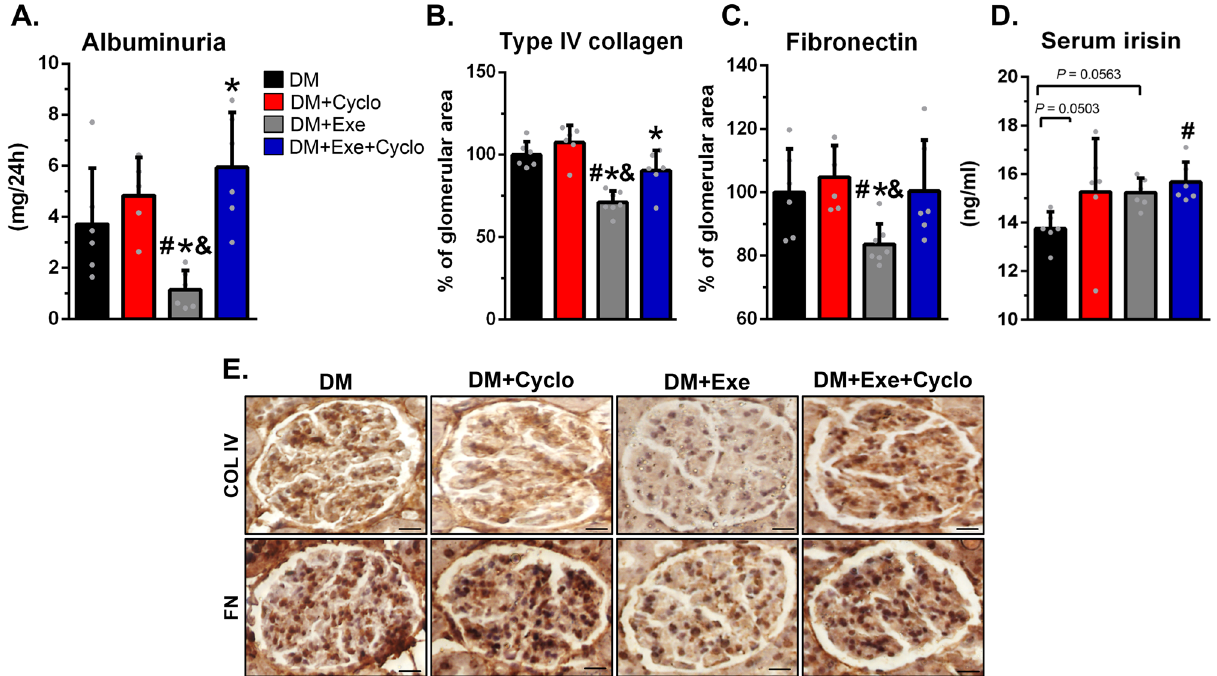
Figure 3. Treatment with an irisin blocker abolished the beneficial effects of aerobic physical exercise in diabetic rats. ( A ) Albuminuria. ( E ) Photomicrography of glomerular immunohistochemistry for type IV collagen and fibronectin (magnification: × 630). ( B , C ) Graphical quantitation of immunohistochemistry for type IV collagen and fibronectin. ( D ) Quantitation of serum irisin levels. Results are means ± SE. DM, sedentary diabetic; DM + Cyclo, sedentary diabetic treated intraperitoneally with 1 mg/kg of αV integrin receptor inhibitor (CycloRGDyK); DM + Exe, exercised diabetic rats; DM + Exe + Cyclo, exercised diabetic treated intraperitoneally with 1 mg/kg of CycloRGDyK. # p < 0.05 vs. DM, * p < 0.05 vs. DM + Cyclo, and & p < 0.05 vs. DM + Exe + Cylo. Scale bars = 20